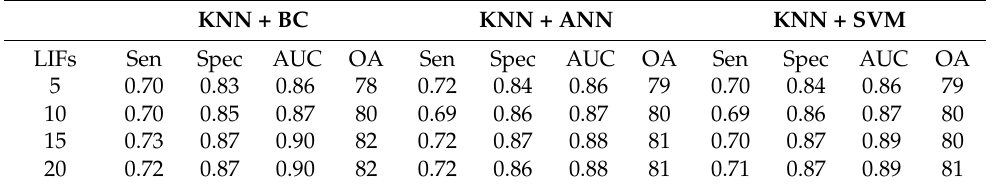
Table 7. Accuracy statistics of ensemble ML models using different sets of LIFs. MS: mean